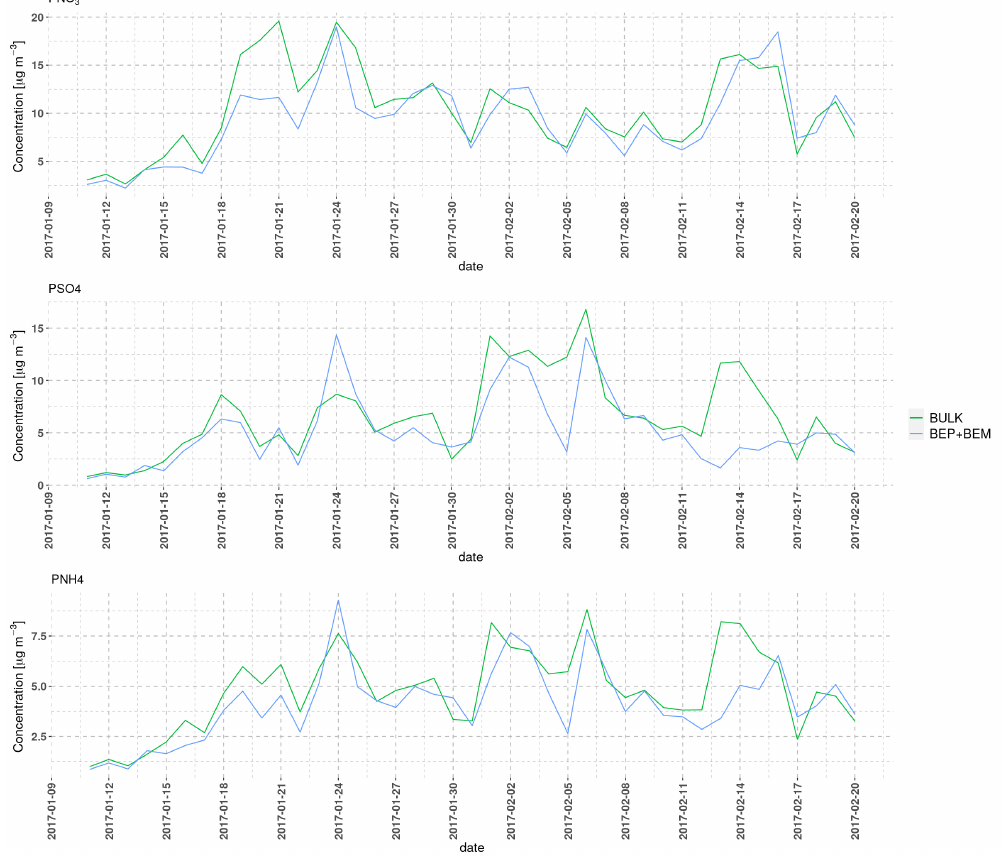
Figure 12. Average daily concentrations of PM secondary inorganic aerosol (nitrates-PNO 3 , sulfates-PSO 4 , and ammonium-PNH 4 ) for BULK simulations (green) and BEP+BEM simulations